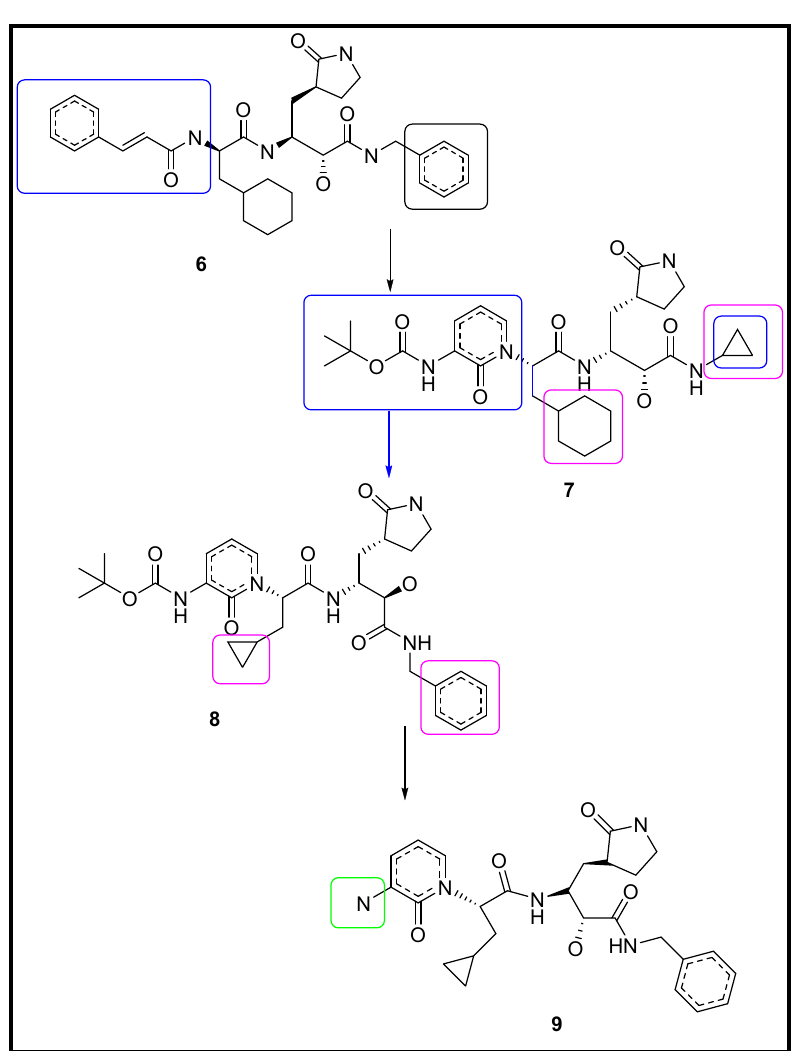
Figure 4. Derivatives of the inhibitor compound 6 : compounds 7–9 .